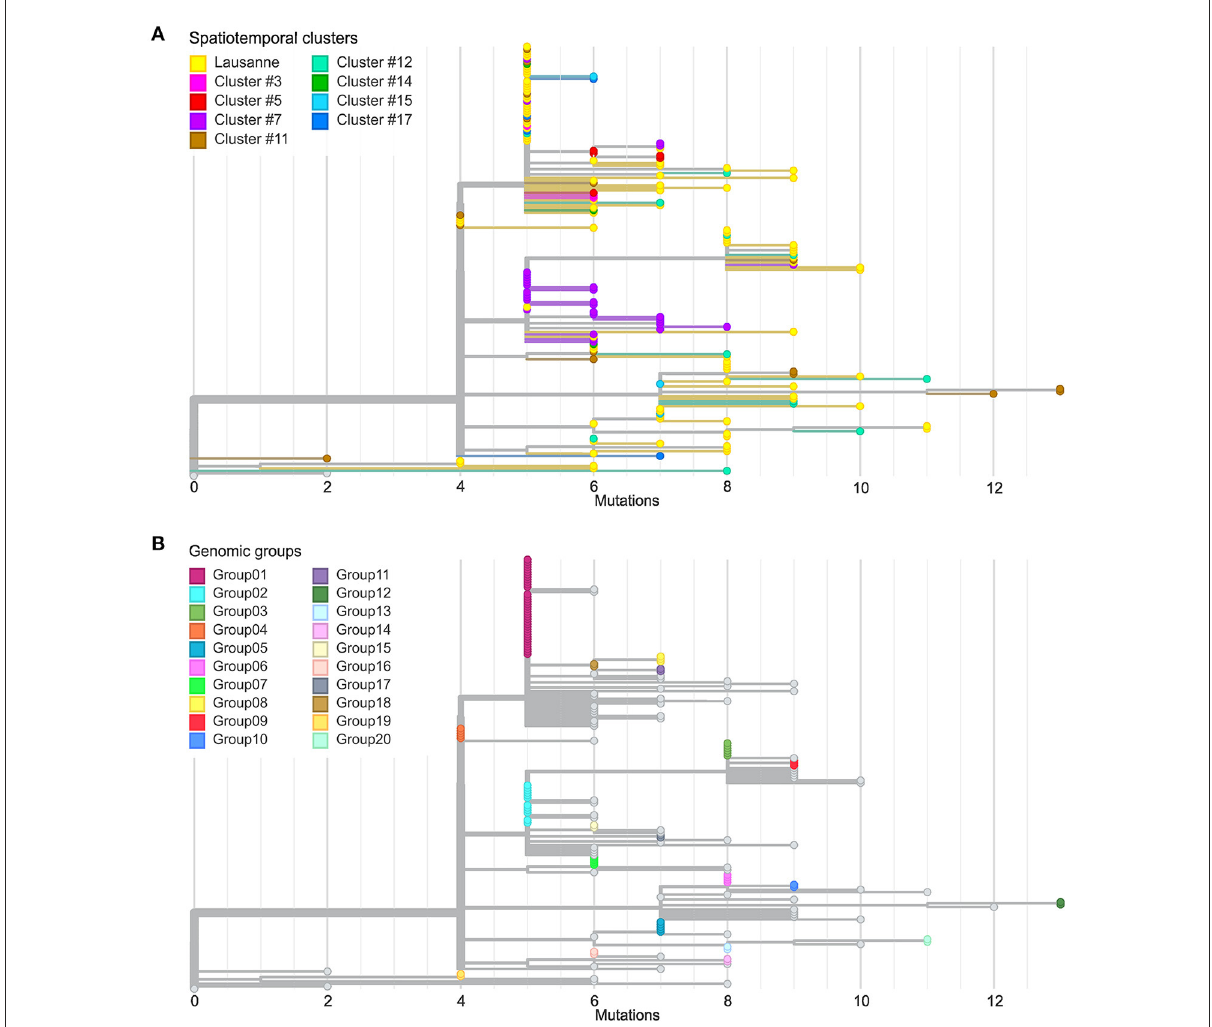
FIGURE3 Comparison between spatiotemporal clusters and genomic groups in phylogenetic trees. (A) Divergence of cases in different geographical regions at SNV level. (B) Definition of genomic groups. Cases with identical genome sequences were assigned to a genomic group. Overall 20 genomic groups were identified with varying numbers of cases within each group. The rest of the cases have unique sequences named